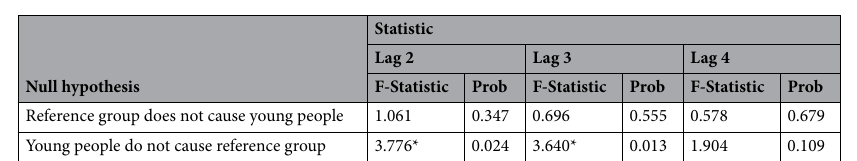
Table 3. Pairwise Granger causality tests results between groups for all sections. Here *p < 0.05.